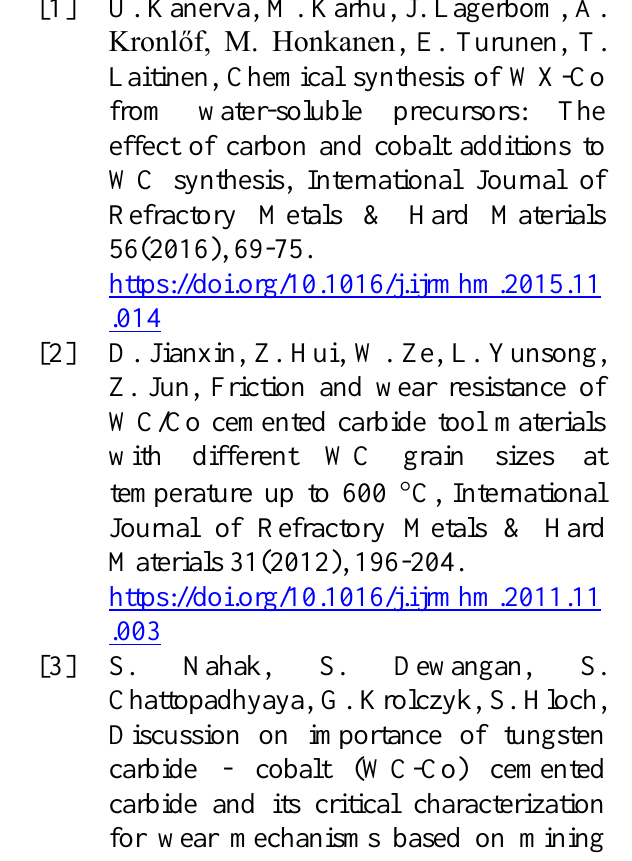
Section Amount, kg Production of granulate 26.23 Compacting 10.00 Pre-sintering 0.00 Forming 5.25 Sintering 0.00 Grinding 0.00 Coating 0.00 Total